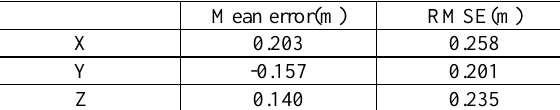
Table 2. The precision of the control SPIs Table 4(b). Mean error and RMSE of the result The precision in height direction is better than horizontal direction. Most difference values are under 1 meter. It is obviously that No.4 SPI is a blunder. The value of mean error and RMSE did not take it into account. The reason for bad result of No. 4 SPI is because the corresponding pair between this SPI and other control SPI was insufficient. Although the quantity of control SPIs matched with each query images are 3, it cannot guarantee the quantity of corresponding pairs is enough. Table 5 shows the quantity of corresponding pairs between each query SPI and control SPIs. Only the top three control SPIs were used to compute the relative orientation Table 3. The residual of check points parameters. The quality of SPI and corresponding pairs affects the positioning result a lot. If SPI contains imperfect geometry such as distortion dose not be removed while composing the SPI. This makes the matching result contain some error conjugate pairs. Once there are incorrect matching pairs, the positioning result of query SPI will be influenced. So make